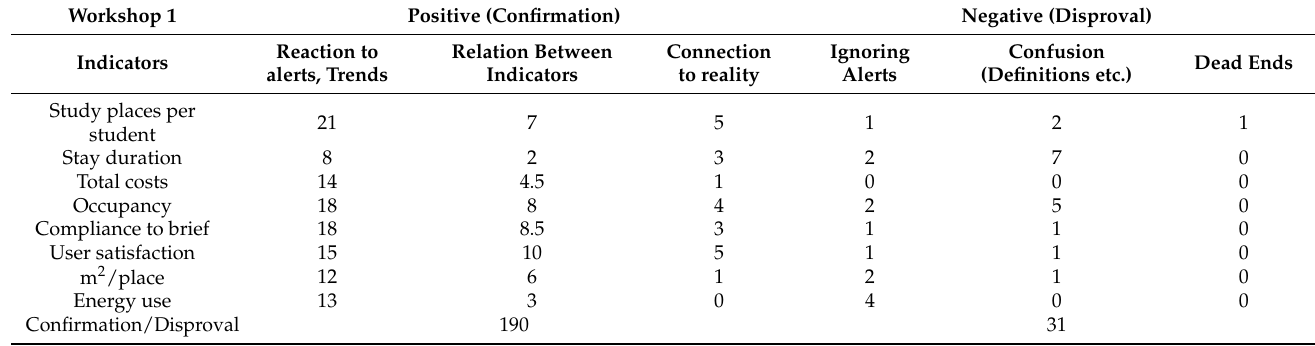
Table A1. Positive and negative interactions of users with the dashboard in workshop 1 (Radboud).